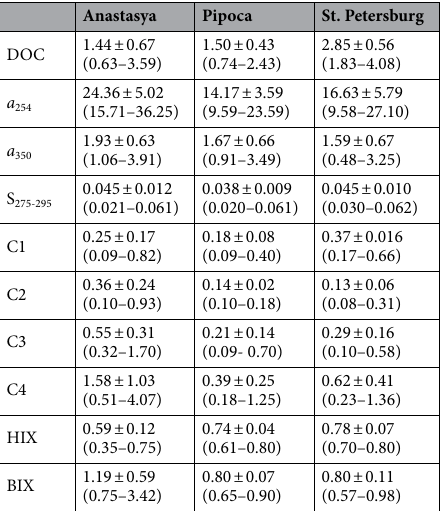
Table 1. Pore water average ± standard deviation values of dissolved organic carbon (DOC, mmol L −1 ), absorption coefficient a 254 and a 350 (m −1 ), the spectral slope S 275-295 (nm −1 ), fluorescent components (C1 to C4, RU), humification (HIX) and freshness (BIX) indexes during June and December 2016 in Anastasya and Pipoca and during June 2016 in St. Petersburg. Interval variations are shown in brackets.